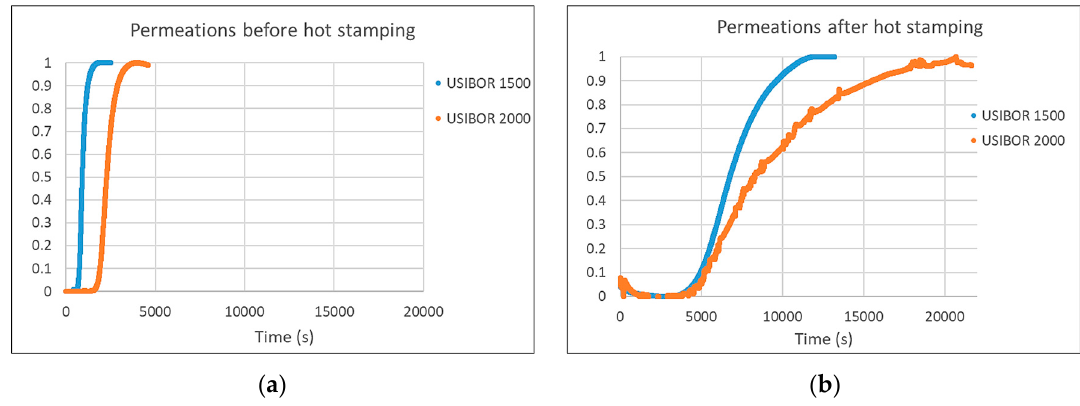
Figure 10. ( a ) Permeation curves before hot stamping. ( b ) Permeation curves after hot stamping.